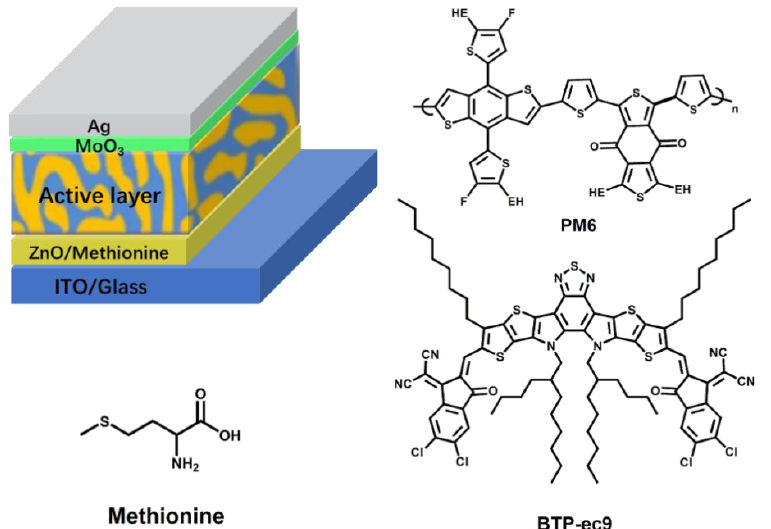
Figure 1. Schematic diagram of the device structure for used OSCs and the chemical structures for the used materials.